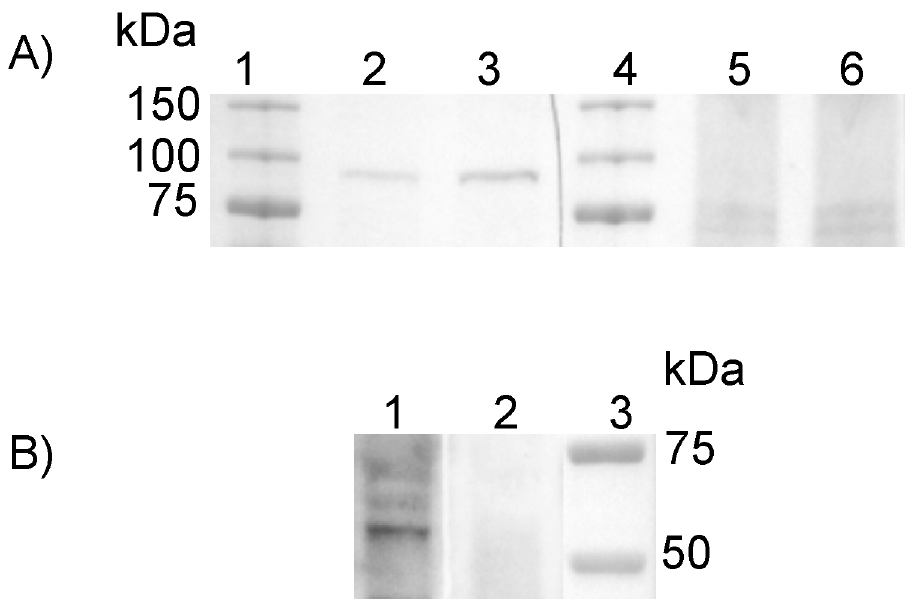
Fig 1. Specificity test for the zfHif-2 α and the zfHif-3 α antibody. A,150 μ g total protein of normoxic (lane 2) and hypoxic (lane 3) zebrafish larvae at 5 dpf have been subjected to SDS electrophoresis. Incubation with the zfHif-2 α specific antibody results in a band at 93 kD. Preincubation of the antibody with recombinant zfHif- 2 α protein eliminates this band (lane 5, normoxic, lane 6, hypoxic sample). Lane 1 and 4 show the marker. B, 150 μ g total protein of hypoxic (lane 1) zebrafish embryo at 3 dpf have been subjected to SDS electrophoresis. Incubation with the zfHif-3 α specific antibody results in a band at 69 kD. Preincubation of the antibody with recombinant zfHif-3 α protein eliminates this band (lane 2). Lane 3 shows the